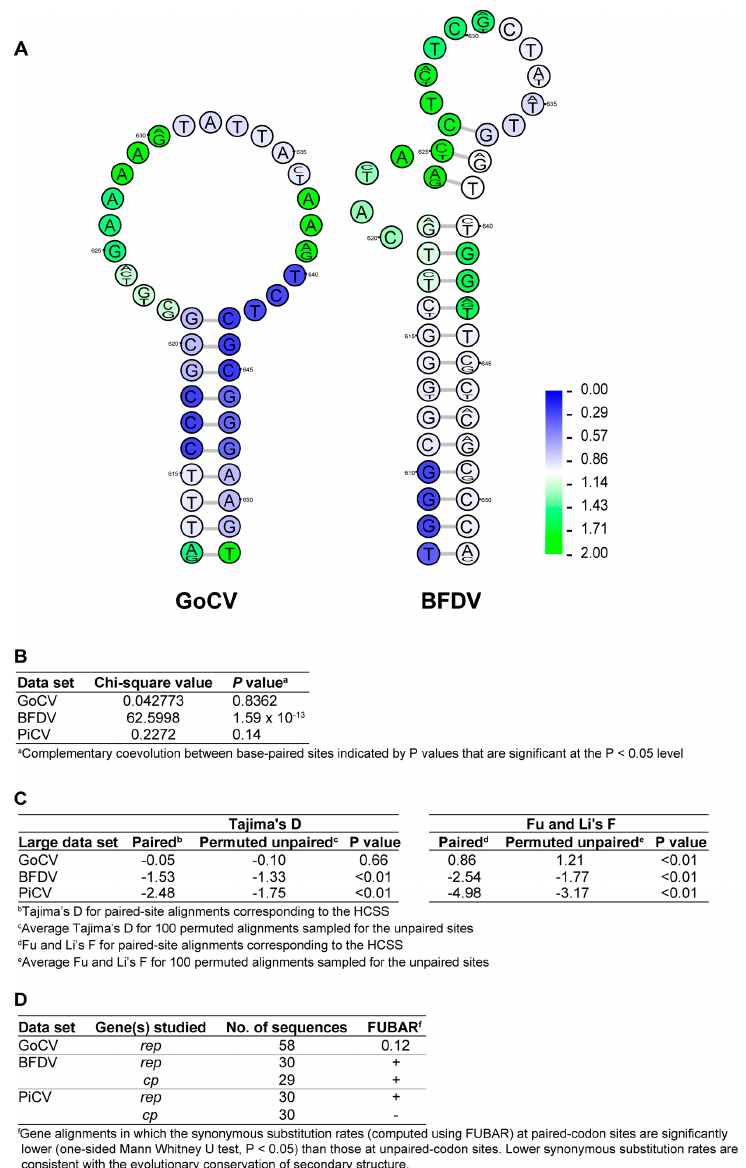
Figure 4. ( A ) Conserved stem-loop structures within rep of GoCV and BFDV genomes. The structures presented are the consensus of all available genomes and were amongst the most highly conserved of all plausible structural elements detected within the genomes of these two species (2nd out of 137 in GoCV and 9th out of 143 in BFDV). The rank ratio indicates the actual conservation rank of the structure over the total number of predicted secondary structures. Nucleotide sequence variability is reflected by a sequence logo at each position, while overlaid synonymous substitution rate estimates are represented by the shading of each nucleotide (ranging from blue for low to green for high). Although these two structures have no obvious sequence similarity, something expected given that GoCV and BFDV groups are very divergent (sharing 58.5% sequence identity), they form within same genomic region in rep and have similar conformation consisting of a stable stem-loop structure with a GC-rich stem-region and with evidence of low synonymous substitution rates in codons occurring within the stem-region consistent with strong selection acting against synonymous substitutions at these sites. ( B ) Association between paired sites and complementarily coevolving sites. ( C ) Tajima’s D and Fu and Li F statistics for paired and unpaired genomic site alignments. ( D ) Comparison of synonymous substitution rates at paired- and unpaired-codon